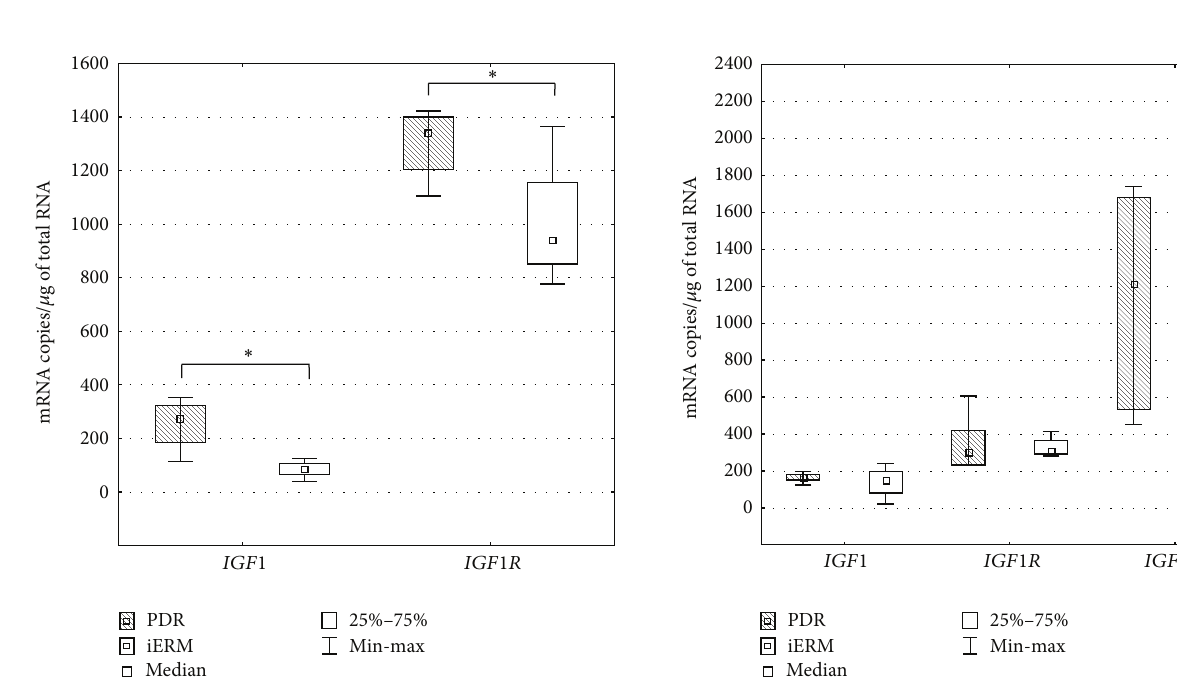
Figure 1: The mRNA levels of IGF1 and IGF1R in epiretinal membranesofpatientswithproliferativediabeticretinopathy(PDR) and in the control subjects with idiopathic ERMs (iERM). (Box and whisker plots present medians ± quartiles and extreme values of copy numbers per 1 𝜇 g of total RNA, statistical significance: ∗ 𝑃 < 0.05 , Mann-Whitney 𝑈 -test).